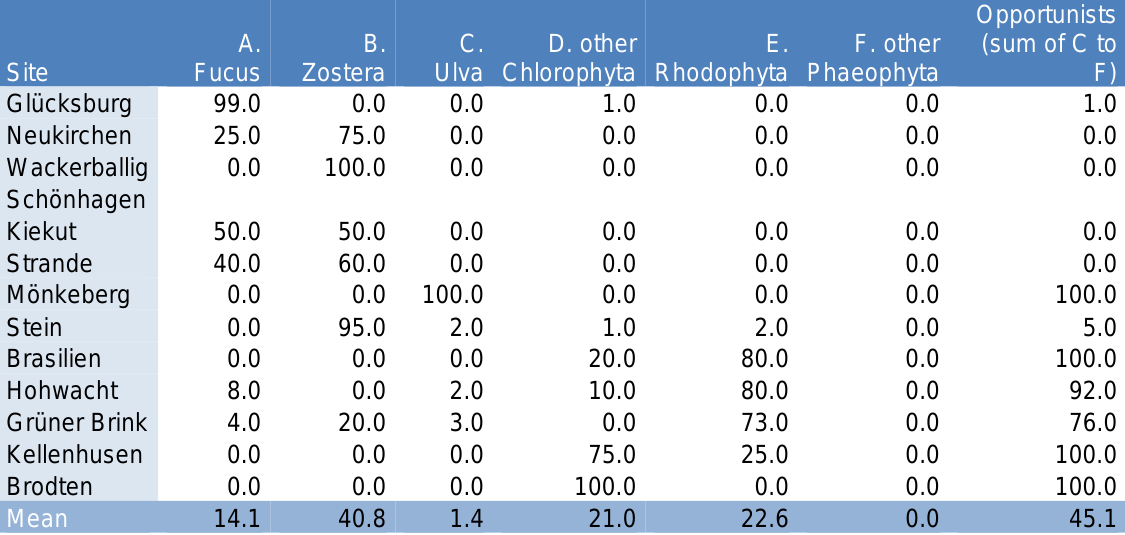
Table S2B: Relative contribution [%] of different macrophytes to dry weight of beach wrack sampled